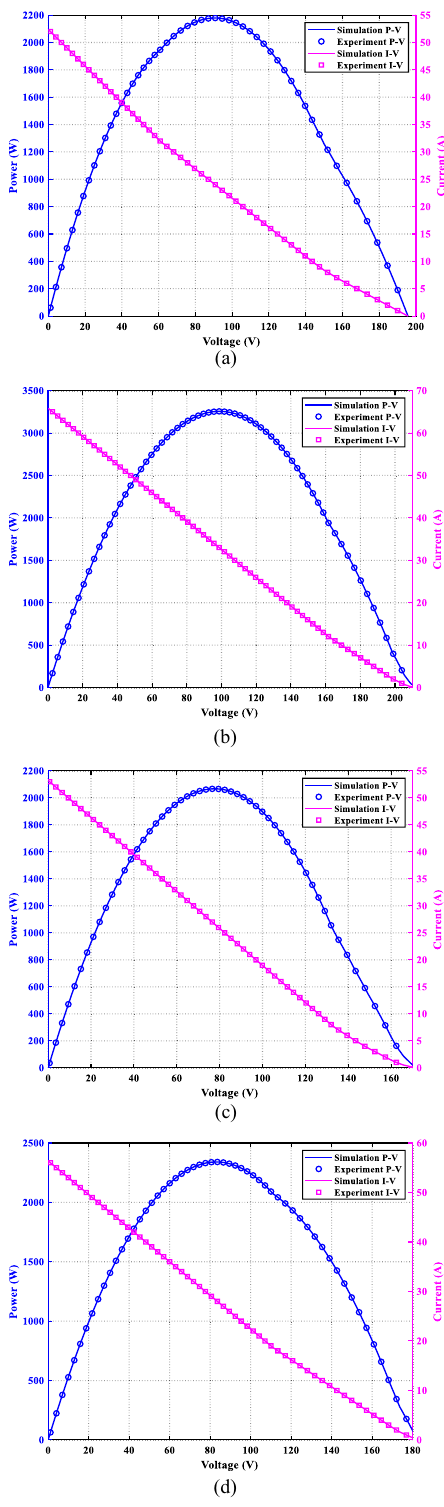
Fig. 17 Output characteristics of (20 and experiment under various HgTDs optimized by ACS: a diagonal, b outer, c inner, and d